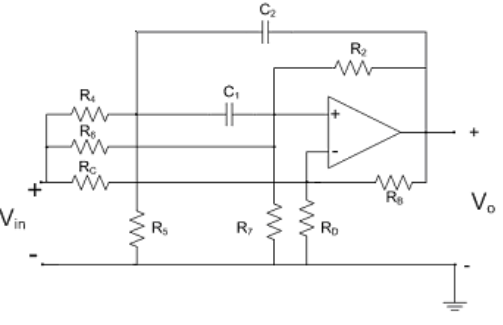
Figure 6. Form of the connection used to design circuit that corresponds to the last factor of the transfer function: Friend’s circuit.